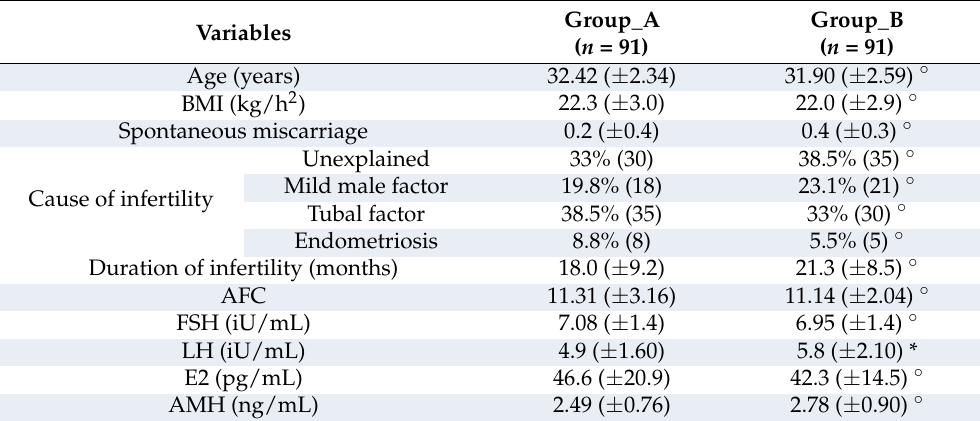
Table 1. General features of the study population (categoric and continuous variables expressed as number/percentage, or mean ± standard deviation,